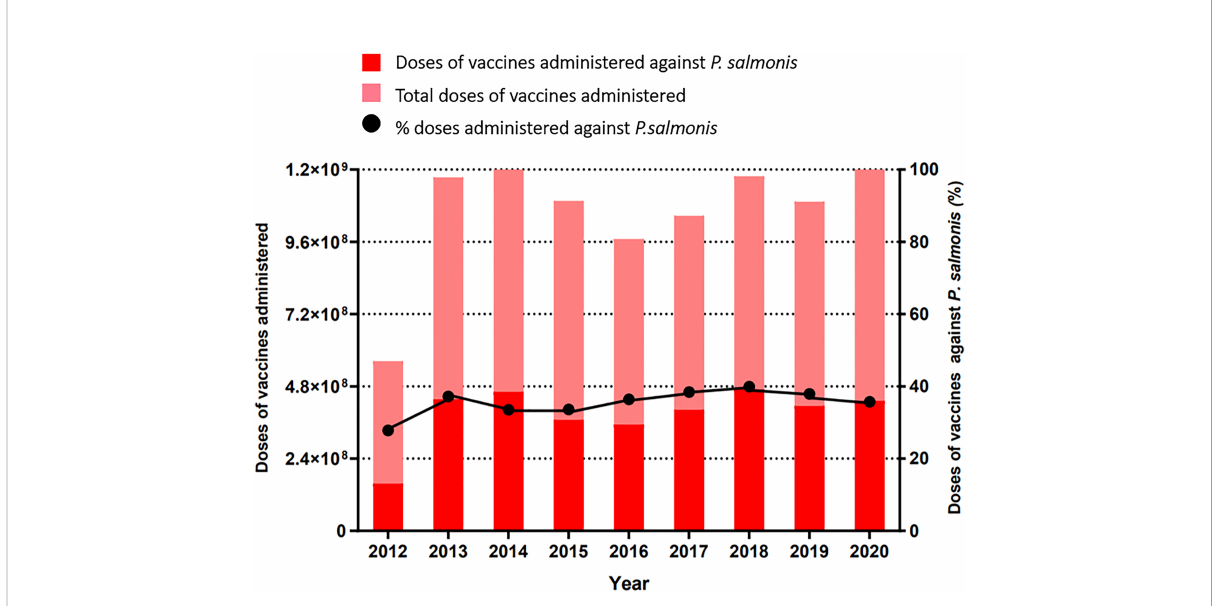
FIGURE 3 Doses of vaccines administrated in Chilean salmon aquaculture (light red) and vaccines administrated to combat Piscirickettsia salmonis (dark red) from 2012 until 2020. Source: National Fisheries Services of Chile, 2022.